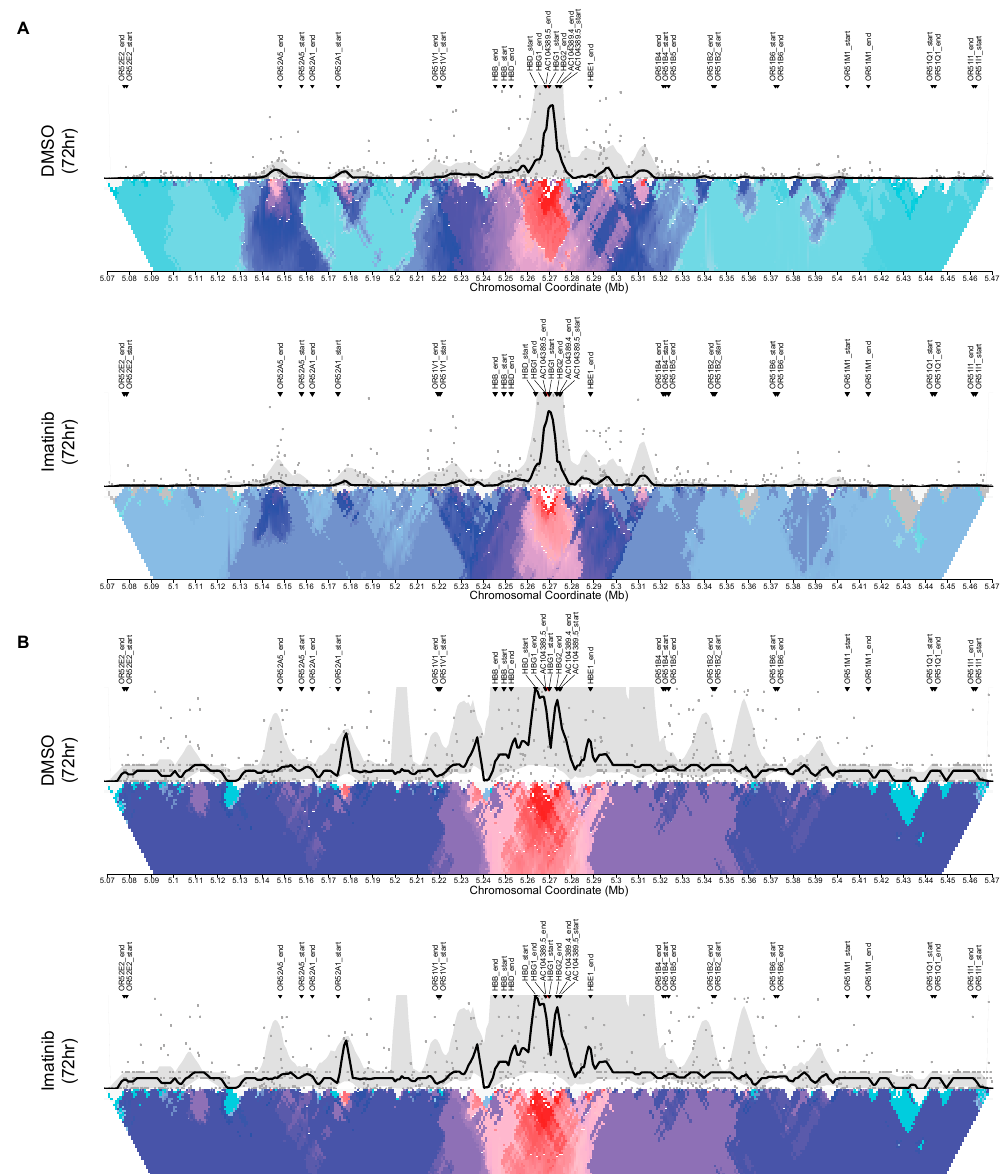
Figure 4. Changes in chromatin arrangement via circular chromosome conformation capture (4c) in K562 and HEL92.1.7 cell lines with imatinib treatment. Libraries were generated using DpnII and Csp61 in subsequent restriction enzyme digestions using primers for the HBG2 promoter (Forward: CAAAGCACCTGGATGATC, Reverse: TTGTCTCTAGCTCCAGTGAG). ( A ) Changes in chromosomal cis-interactions with HBG2 promoter on chromosome 11 with imatinib treatment in K562 cells; ( B ) Changes in chromosomal cis-interactions with HBG2 promoter on chromosome 11 with imatinib treatment in HEL92.1.7